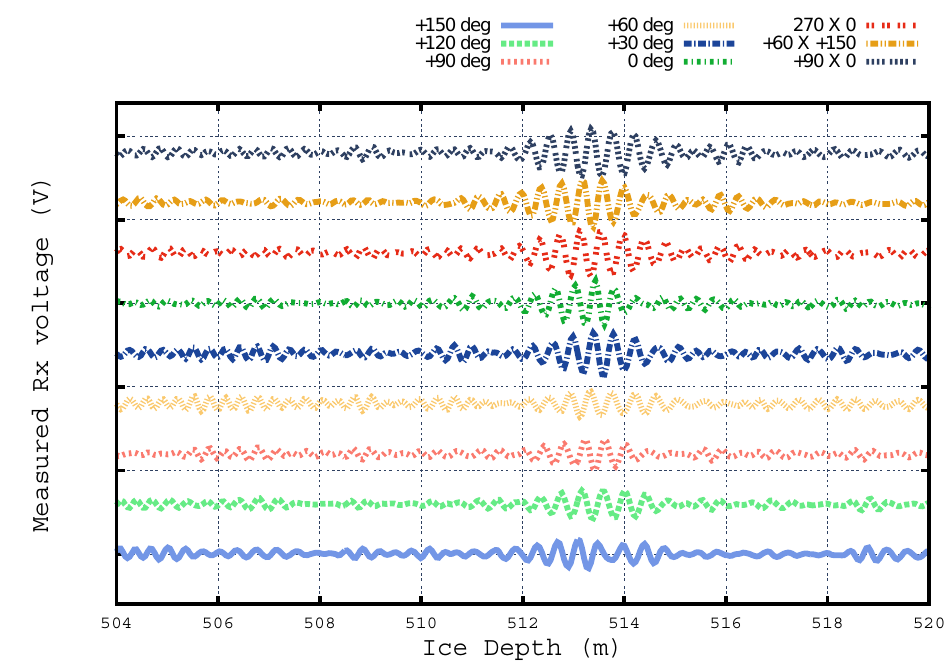
Fig. 5. Zoom of interval around 6µs, converted to depth. Vertical divisions correspond to 10mV. No horizontal offset has been applied to successive waveforms. Each 2 meter division horizontally corresponds to approximately